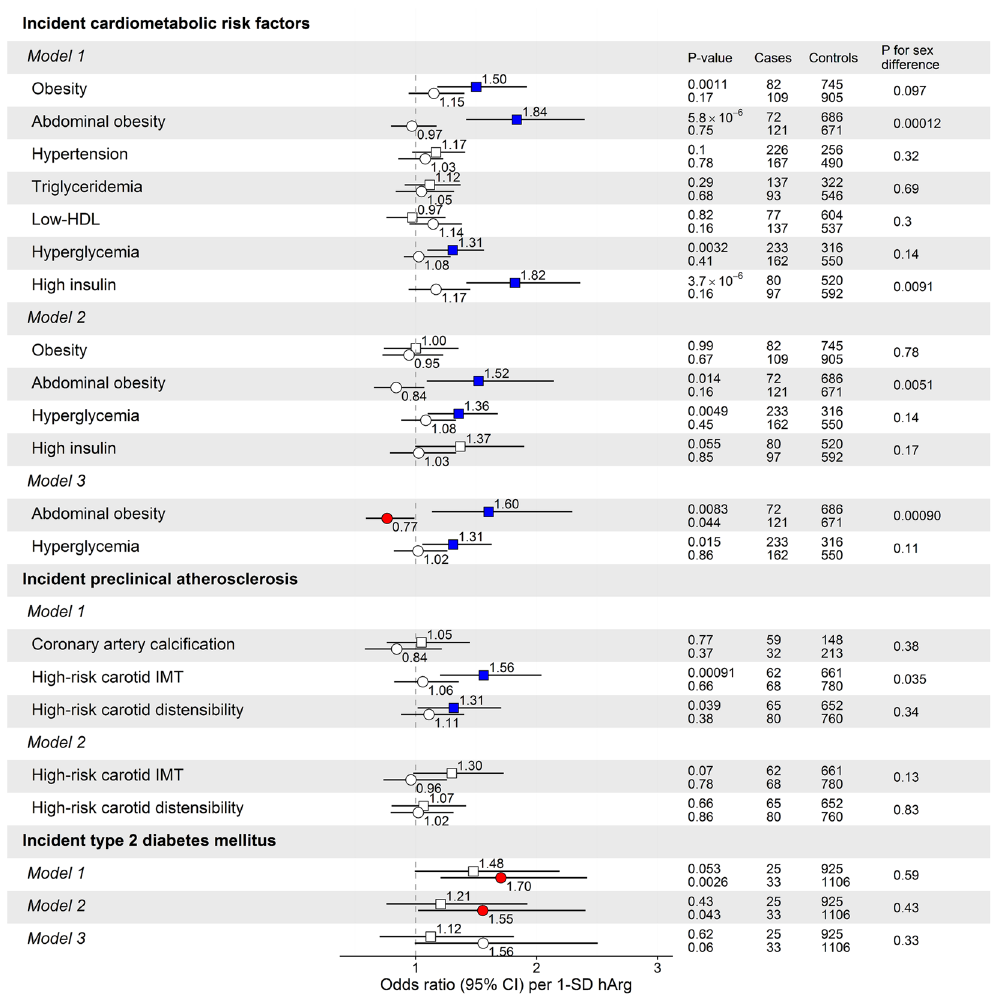
Figure 3. Sex-specific prospective (observational) associations of baseline hArg (in 2001) and cardiometabolic risk factors, preclinical atherosclerosis and type 2 diabetes mellitus (T2DM) during a 10-year follow-up in YFS. The prospective associations are shown as unadjusted (Model 1), adjusted for all baseline cardiometabolic risk factors shown in Table 1 (Model 2), and further adjusted for baseline serum steroid hormone binding globulin (SHBG) and oral contraceptive use in women. Open and closed squares and circles indicate P ≥ 0.05 and P < 0.05,